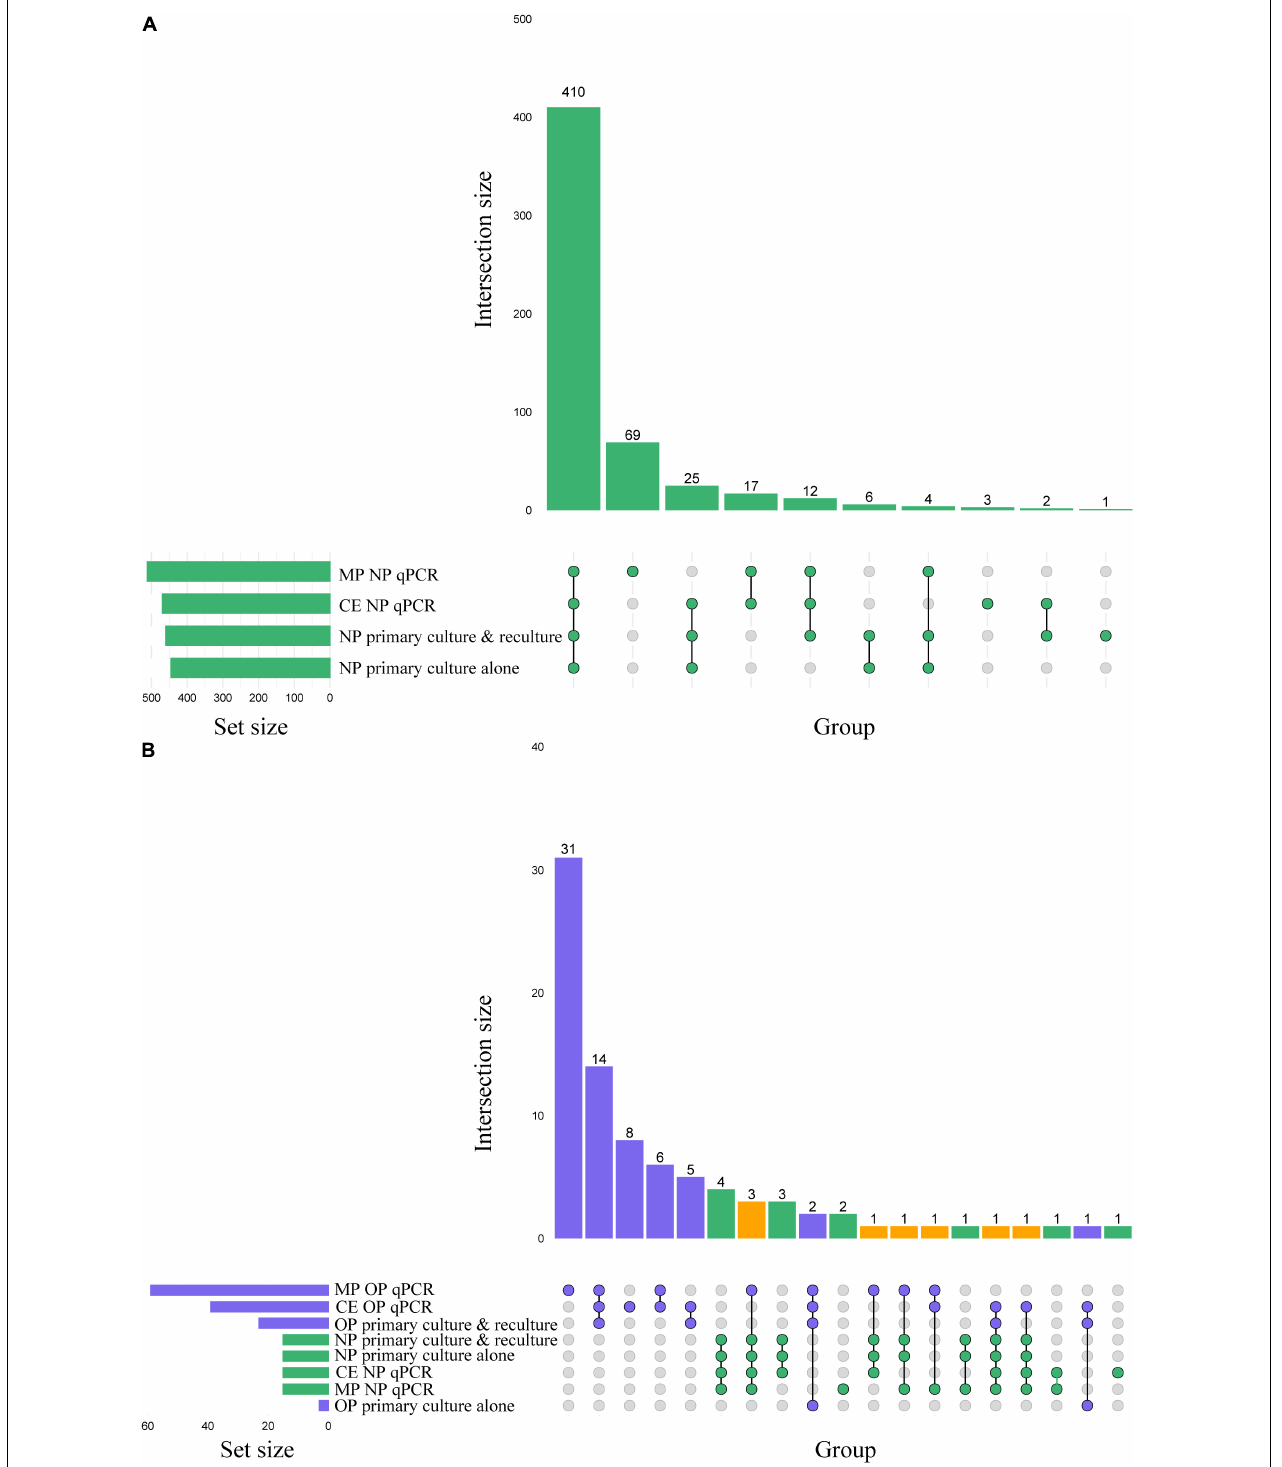
FIGURE 2 | (A) Matrix layout for observed intersections of the Streptococcus pneumoniae detection procedures applied to n = 1,549 nasopharyngeal (NP) samples, sorted by size. (B) Matrix layout for observed intersections of the S. pneumoniae detection procedures applied to nasopharyngeal and oropharyngeal (OP) samples from n = 319 adults sampled in the Netherlands, sorted by size. Circles in the matrix indicate sets that are part of the intersection, with nasopharyngeal and oropharyngeal samples colored in green and blue, respectively. The bar diagram displaying the intersection size is colored using the same scheme, with orange indicating an intersection that represents positivity in both sample types. MP stands for minimally processed and CE for culture-enriched.